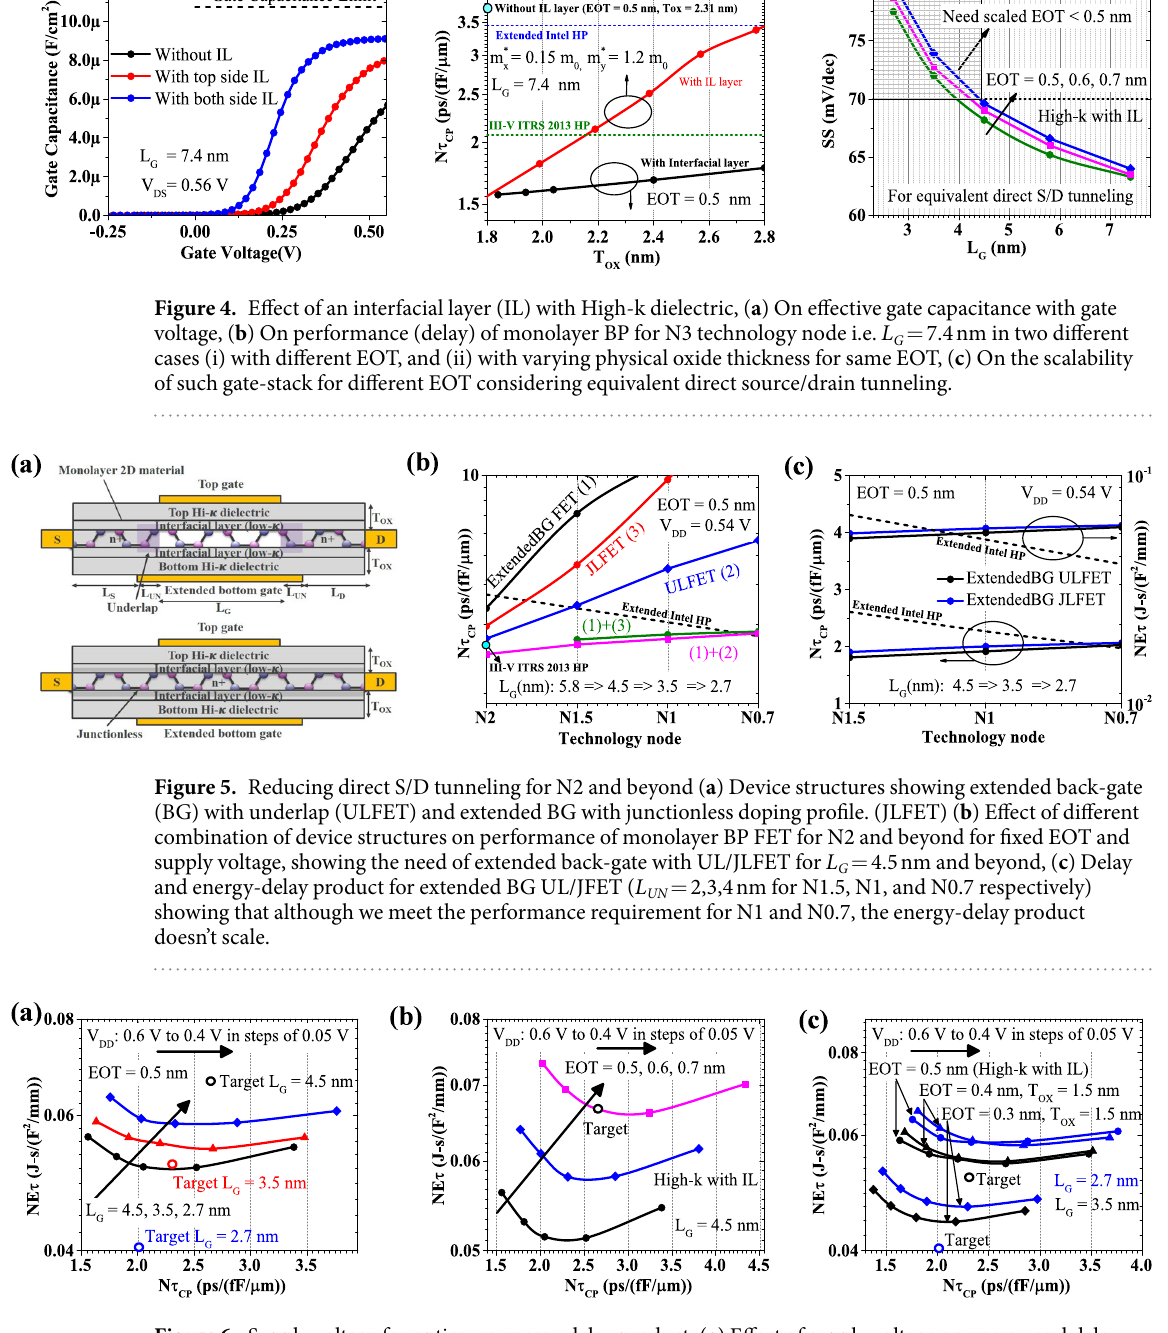
Figure 6. Supply voltage for optimum energy delay product, ( a ) Effect of supply voltage on energy and delay for fixed EOT = 0.5 nm, and L G = 3.5, and 2.7 nm. ( b ) Effect of EOT scaling on energy-delay Vs delay plot for L G = 4.5 nm, ( c ) For L G = 3.5 nm, and L G = 2.7